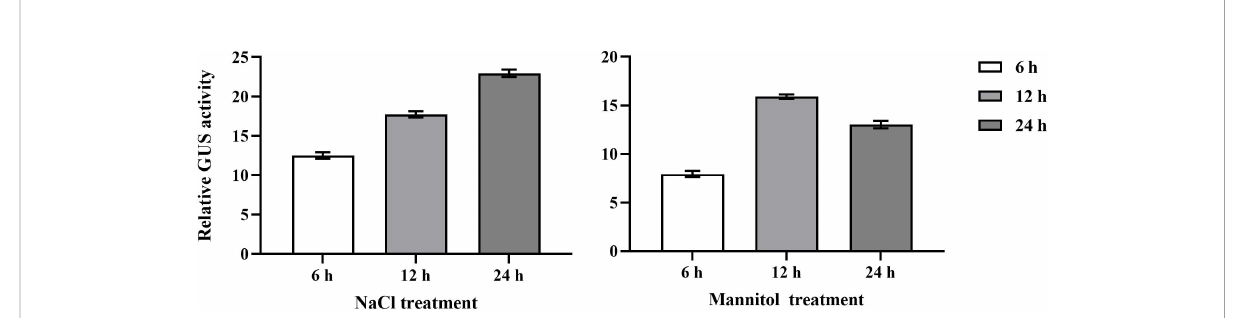
FIGURE 2 Relative activity of GUS in transient transgenic BplMYB46 promoter:: GUS birch plants under salt and osmotic stress. Relative activity of GUS under salt stress of 150 mM NaCl and osmotic stress of 200 mM mannitol for 6 h, 12h and 24 h. BplMYB46 promoter:: GUS construct was transformed into one-month-old birch plants using the Agrobacterium tumefaciens -mediated transient transformation method. The relative activity of GUS mean that the relative level of GUS in transient transgenic BplMYB46 promoter:: GUS birch plants under salt and osmotic stress, compared with that in transient transgenic BplMYB46 promoter :: GUS birch plants under water treatment. Error bars indicate the standard deviation of three biological replicates.